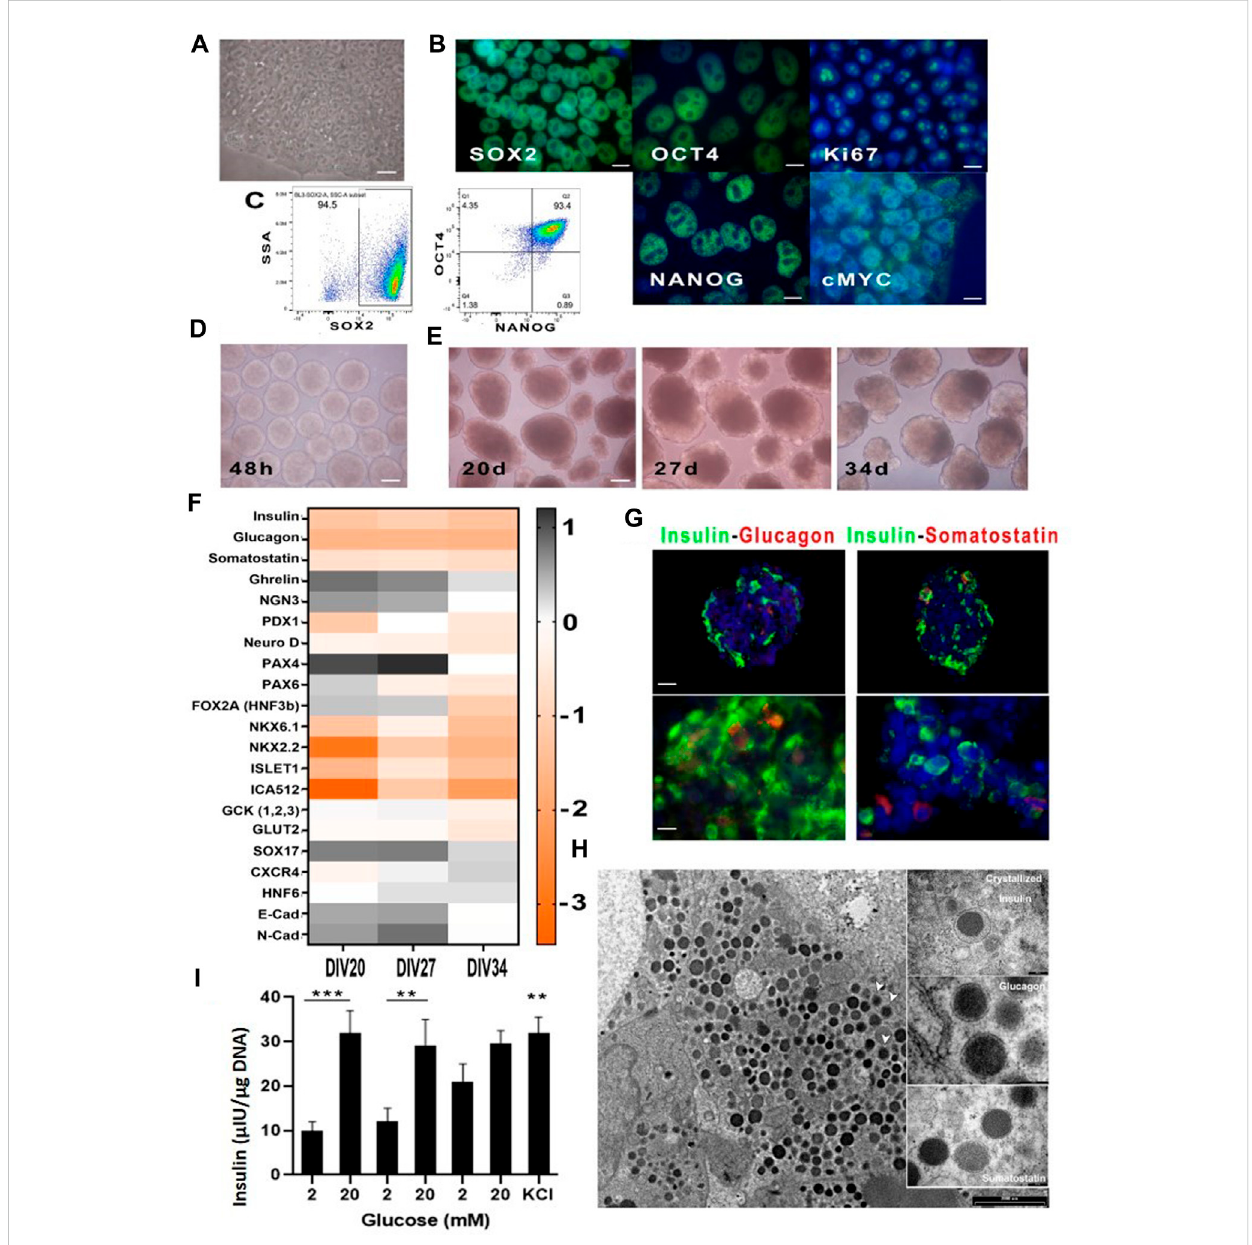
Cultured hiPSC in Nutristem medium before and after differentiation. (A) hiPSC cultured on vitronectin XFTM and NutriStem XFTM before differentiation (40X); (B) Immuno fl uorescence analysis for the indicated stem cell markers (100X); (C) Representative cyto fl uorimetric dot plots showing triplepositivityto Sox2, Oct4and Nanogover 90% ofbasal hiPSC; (D) Spheroidsafter 48 hofmechanical aggregation justbefore differentiation initiation (4X); (E) Spheroids ’ morphology at time three of terminal differentiation (10X); (F) qPCR for indicated messengers at time three of terminal differentiation; (G) Immuno fl uorescence analysis of cell spheroids at Div27 for insulin-glucagon and insulin-somatostatin: presence of single hormone producing cells was evident (20X, 100X); (H) TEM micrographs showing insulin granuli in the cell cytoplasm; white arrows indicate vesicles with crystallized insulin inside them. Photographs in the boxes on the right show enlargements of hormone vesicles found in other spheroids ’ cells; (I) Static incubation performed on cell spheroids at Div27, was associated with near physiological insulin secretory patterns in response to glucose; also evident was the presence of residual insulin after KCl addition indicating correct cell differentiation. *** p < 0.0001 comparison of 2 mM and 20 mM fi rst stimulation ** p < 0.005 for comparison of second stimulation. n.s not signi fi cant for third stimulation. KCl signi fi cant with p < 0.005 in the comparison of 2 mM of the fi rst and second